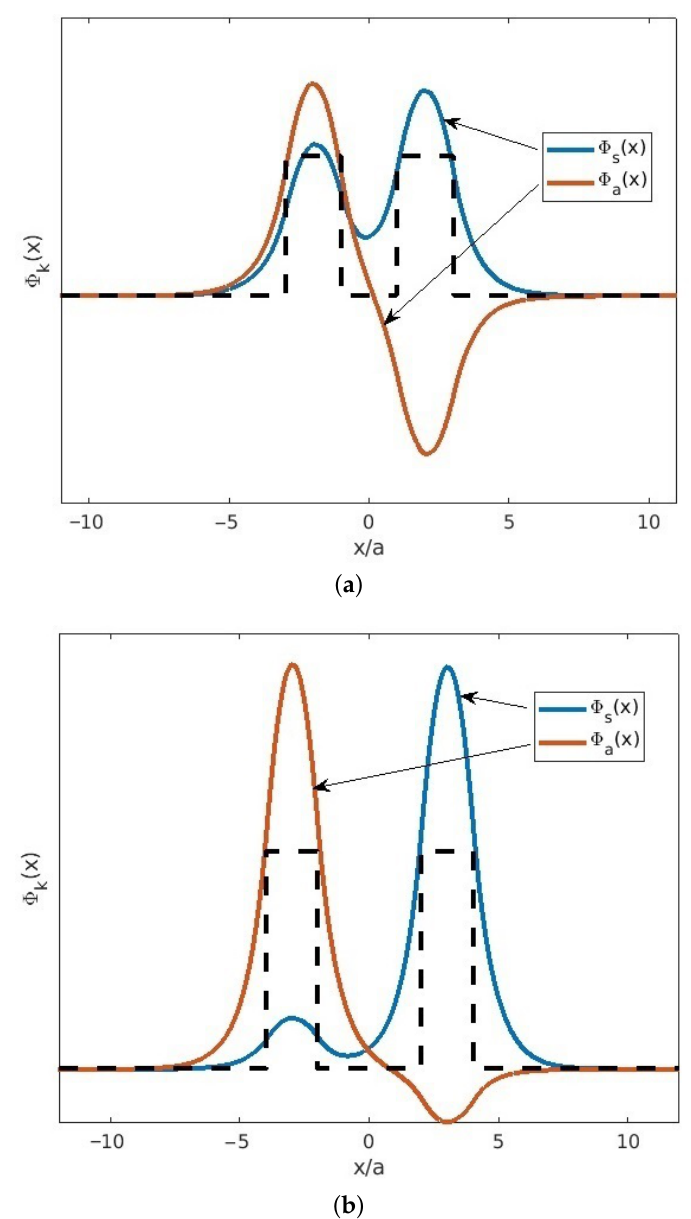
Figure 4. Spatial modes for slab guides with widths w 1 = 7.9 µ m and w 2 = 8.1 µ m (the wider guide is on the right). In this case, we define a = ( w 1 + w 2 ) /4. The normalised frequency for an averaged guide is v = π /2. Note that, as the guide separation increases, the s mode becomes more greatly confined to the wider guide, whilst the a mode is confined to the narrower. ( a ) Spatial modes for unequal guides with d / a = 1. ( b ) Spatial modes for unequal guides with d / a =